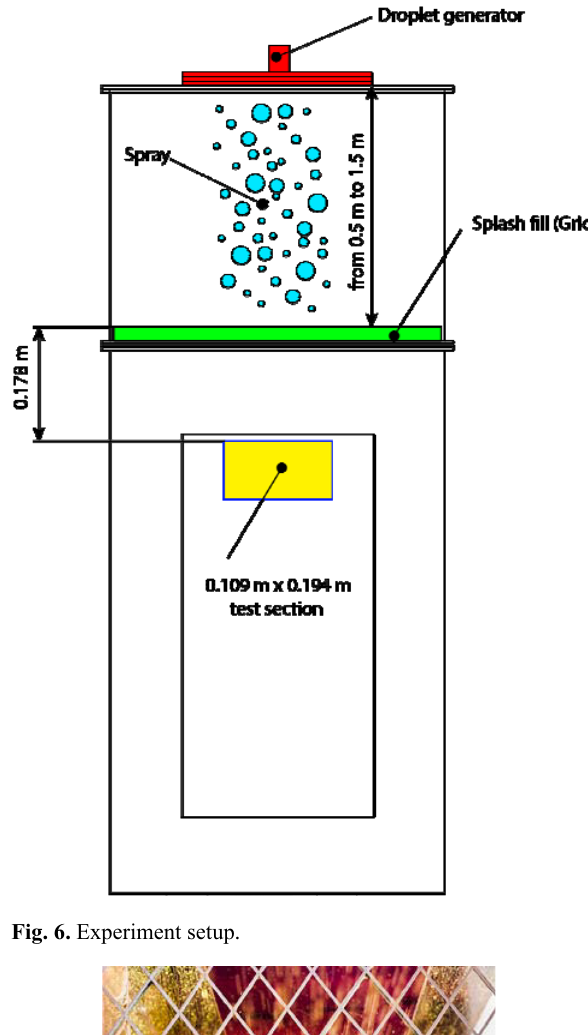
Fig. 6. Experiment setup .